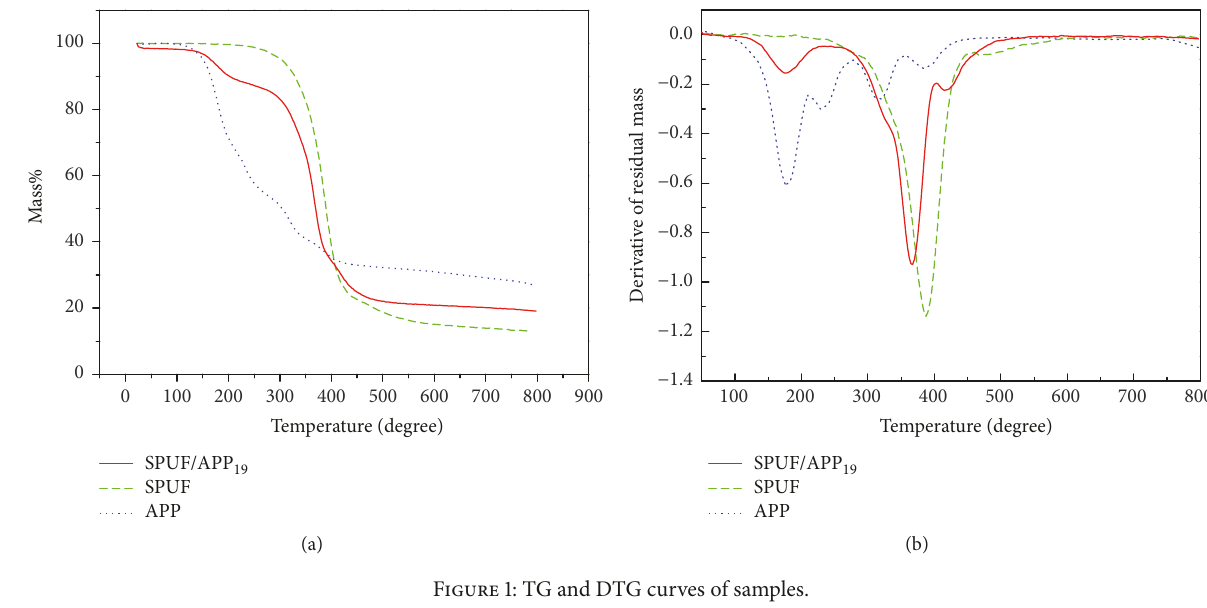
Figure 1: TG and DTG curves of samples.